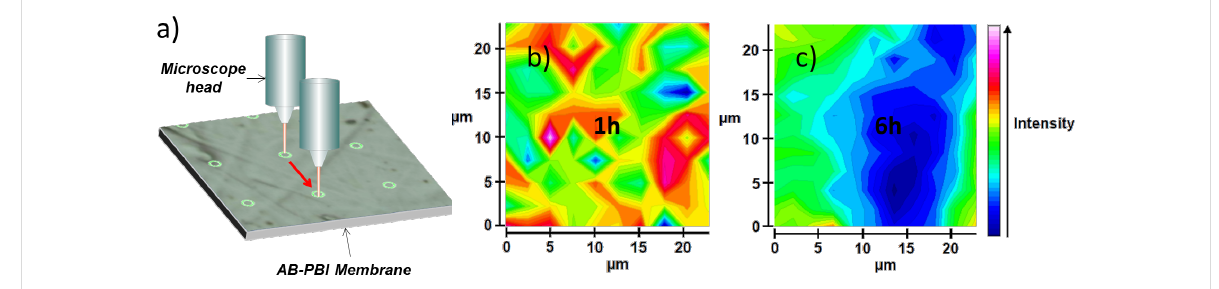
Figure 10: (a) Schematic drawing of confocal Raman microscopy mapping. Confocal Raman maps of phosphoric-acid-doped AB-PBI membranes. The membrane sheets were immersed in a 120 °C hot phosphoric acid bath for (b) 1 h and (c) 6 h. The Raman images show an increasing homo- geneity of the phosphoric acid distribution in the membrane with prolonged doping time. Reproduced with permission from [34]. Copyright 2014 Elsevier.